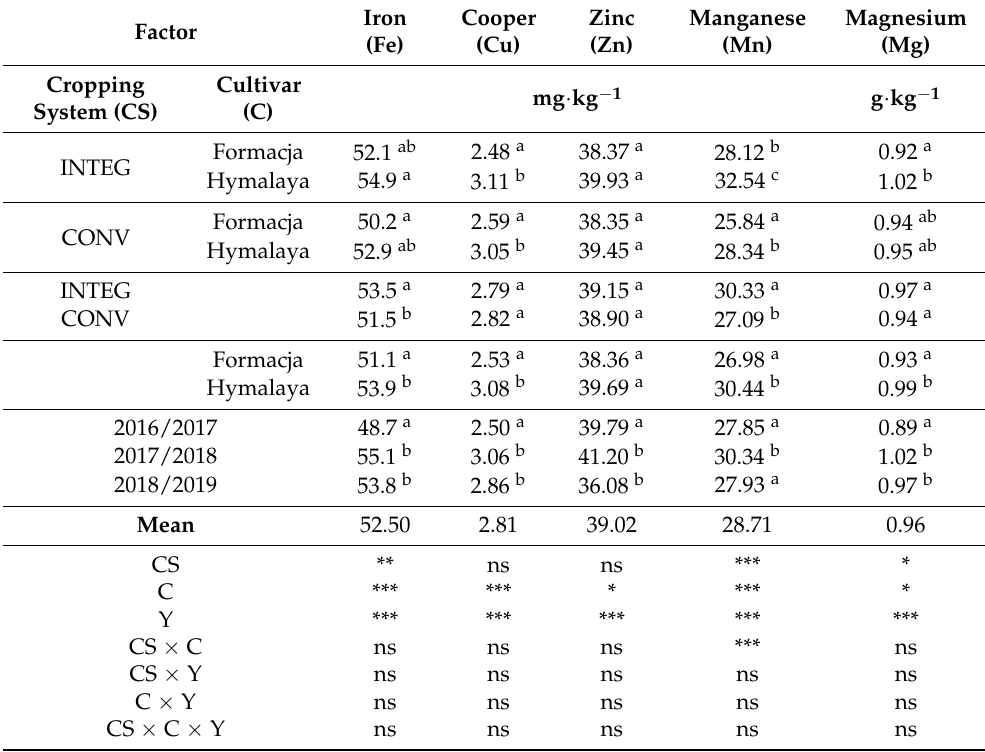
Table 8. Effect of cropping system and cultivar on the mineral composition. Factor